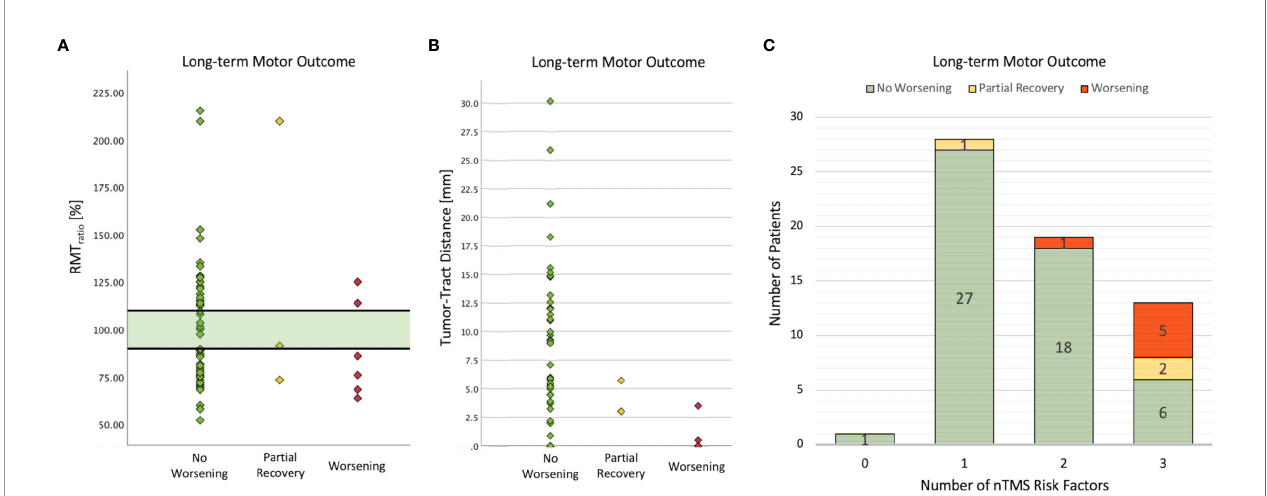
FIGURE 2 | Analysis of nTMS risk factors and long-term motor outcome. No patient suffered a new permanent motor de fi cit when the RMT ratio was between 90% and 110% (A) . Only one patient developed a postoperative paresis which recovered partially within 3 months. The lower the TTD was, the higher was the risk of postoperative motor deterioration (B) . Note that 4 patients in the worsening group had a TTD of 0 mm. Thus, in addition to the recently proposed safe TTD of 8mm, the entire nTMS risk strati fi cation was con fi rmed in this cohort (C)